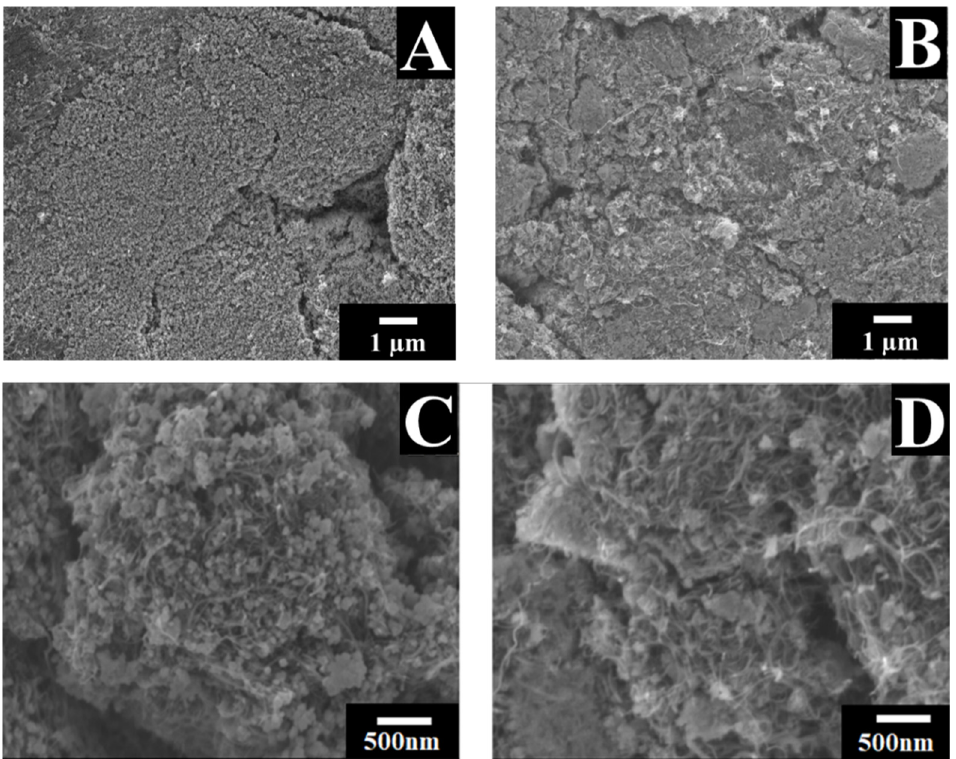
Figure 3. SEM images at different magnifications for electrodes prepared by ( A , C ) method 1 and ( B , D ) method 2.